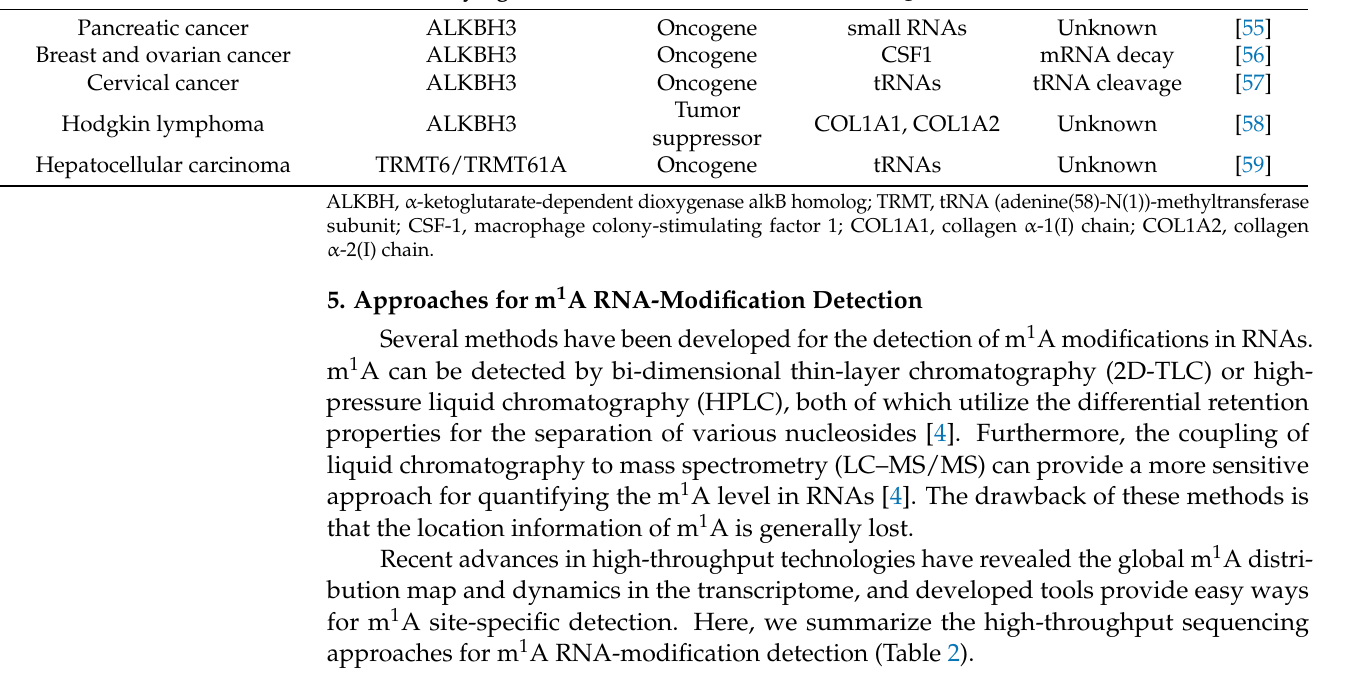
Table 2. Detection methods for mapping m 1 A RNA